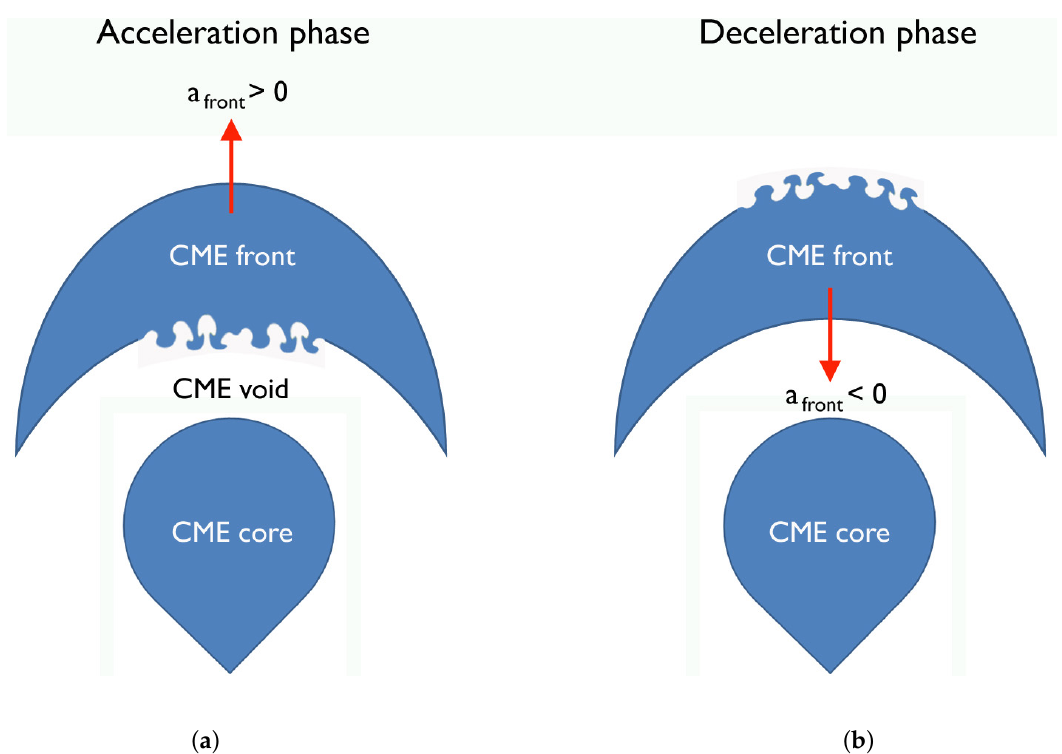
Figure 6. Two possible locations for the generation of RT plasma instabilities at the CME front during the acceleration ( a ) and the deceleration ( b ) phases (see